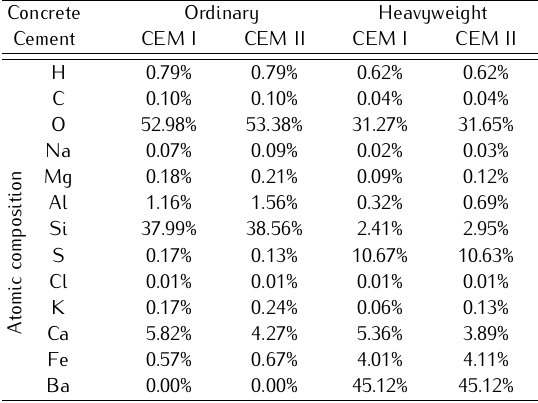
Table 6. Volume composition of ordinary and heavyweight con- crete for MCNPX and SPOT simulations.